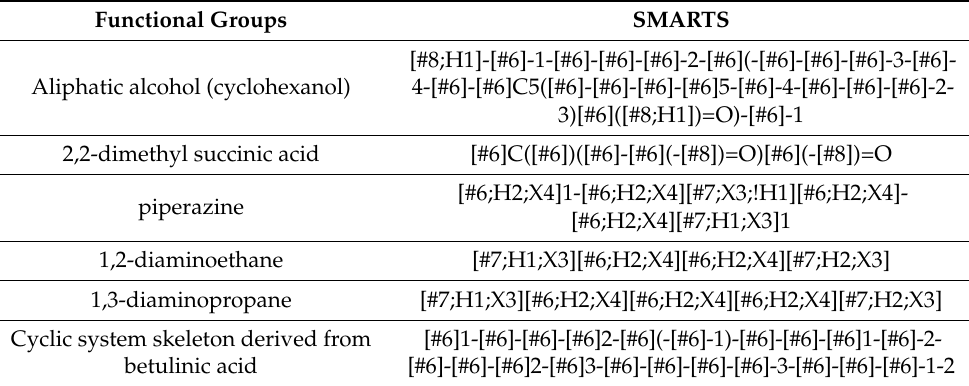
Table 3. Functional groups using SMARTS notation to filter fragments from natural